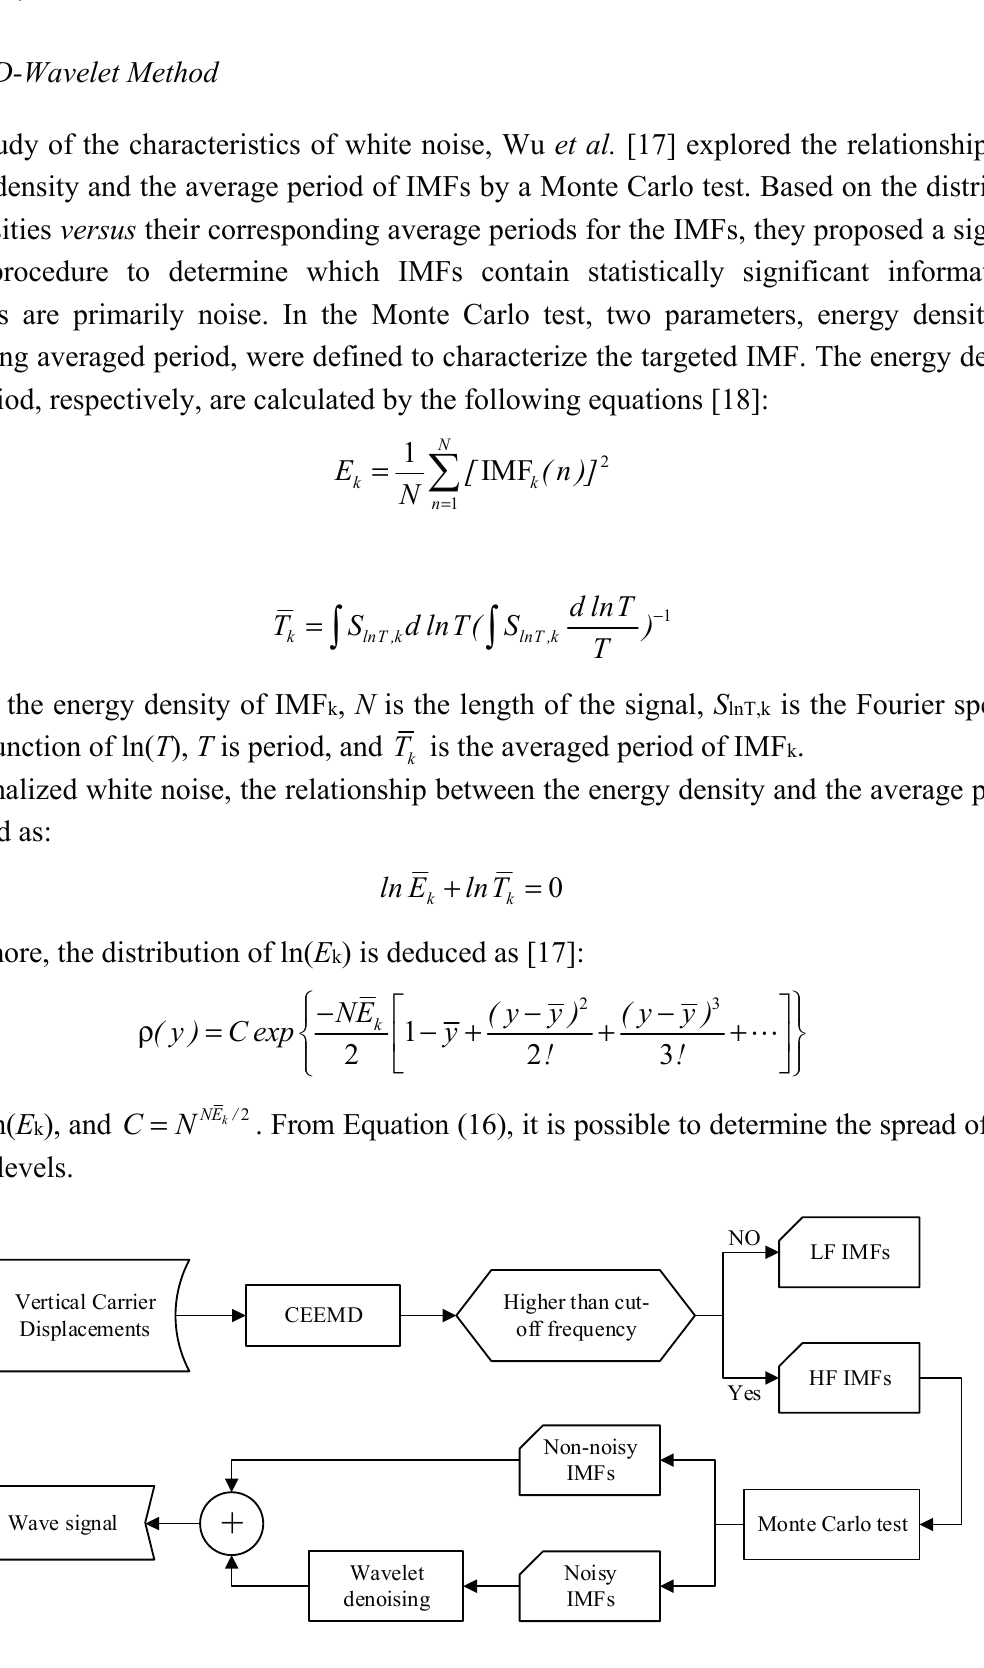
Figure 1. The flowchart of CEEMD-Wavelet wave separation